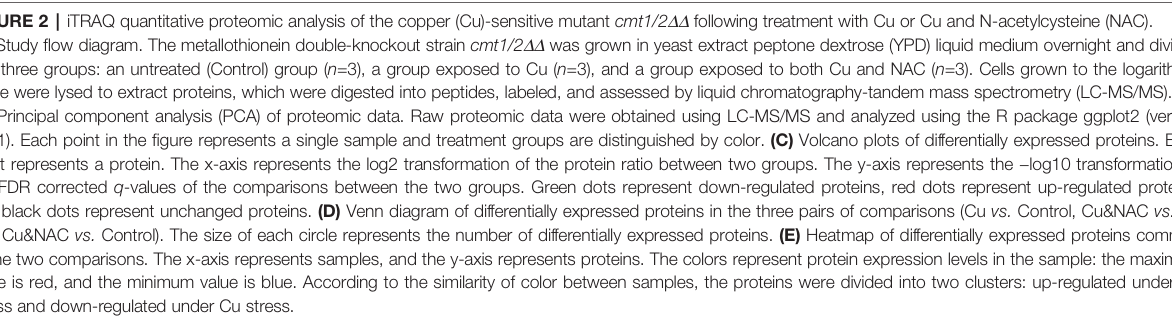
FIGURE 2 | iTRAQ quantitative proteomic analysis of the copper (Cu)-sensitive mutant cmt1/2 DD following treatment with Cu or Cu and N-acetylcysteine (NAC). (A) Study fl ow diagram. The metallothionein double-knockout strain cmt1/2 DD was grown in yeast extract peptone dextrose (YPD) liquid medium overnight and divided into three groups: an untreated (Control) group ( n =3), a group exposed to Cu ( n =3), and a group exposed to both Cu and NAC ( n =3). Cells grown to the logarithmic stage were lysed to extract proteins, which were digested into peptides, labeled, and assessed by liquid chromatography-tandem mass spectrometry (LC-MS/MS). (B) Principal component analysis (PCA) of proteomic data. Raw proteomic data were obtained using LC-MS/MS and analyzed using the R package ggplot2 (version 3.2.1). Each point in the fi gure represents a single sample and treatment groups are distinguished by color. (C) Volcano plots of differentially expressed proteins. Each point represents a protein. The x-axis represents the log2 transformation of the protein ratio between two groups. The y-axis represents the − log10 transformation of the FDR corrected q -values of the comparisons between the two groups. Green dots represent down-regulated proteins, red dots represent up-regulated proteins, and black dots represent unchanged proteins. (D) Venn diagram of differentially expressed proteins in the three pairs of comparisons (Cu vs. Control, Cu&NAC vs. Cu and Cu&NAC vs. Control). The size of each circle represents the number of differentially expressed proteins. (E) Heatmap of differentially expressed proteins common to the two comparisons. The x-axis represents samples, and the y-axis represents proteins. The colors represent protein expression levels in the sample: the maximum value is red, and the minimum value is blue. According to the similarity of color between samples, the proteins were divided into two clusters: up-regulated under Cu stress and down-regulated under